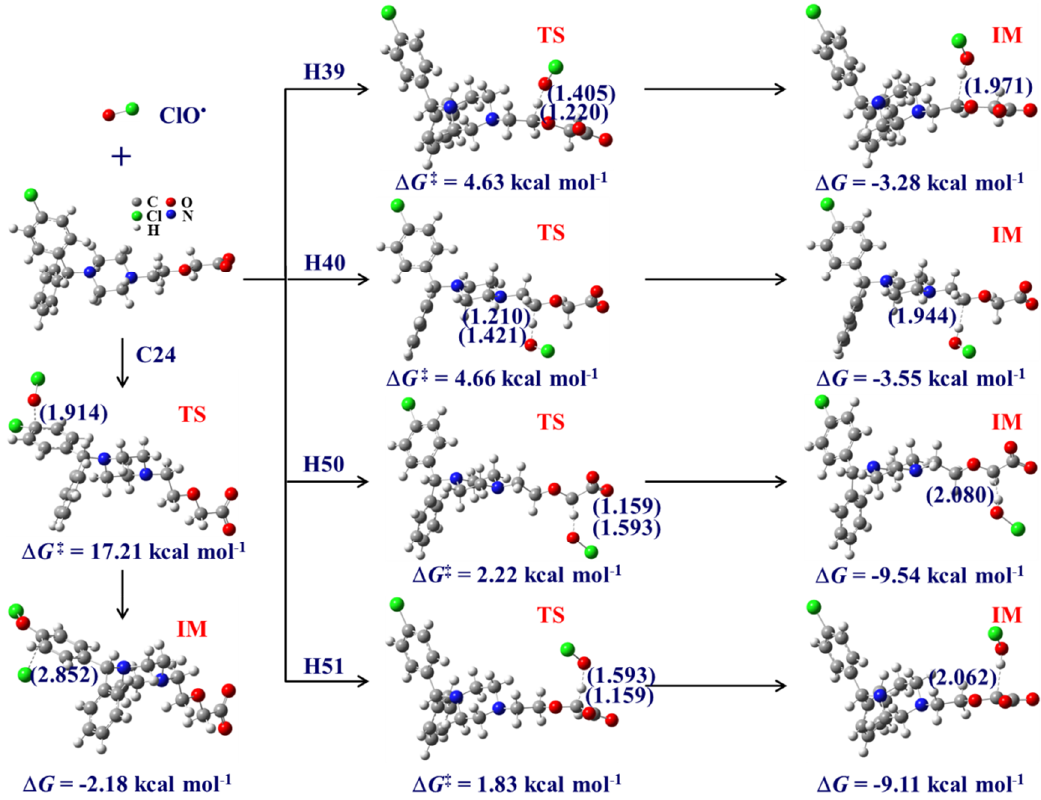
Figure 7. Detailed addition (C24 site) and H-abstraction (H39, H40, H50, and H51) pathways for the reaction of CTZ + ClO • (the values in the brackets are length of bonds marked with the dashed lines, and the unit is Å; TS and IM denote transition state and intermediate, respectively).